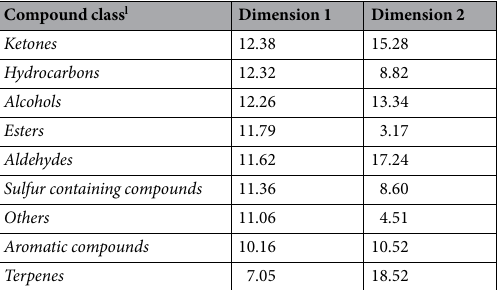
Table 2. Compound classes and their relative contribution to the MFA dimensions for the PTR-TOF analysis. Each dimension of a multivariate analysis can be described by the variables that are used to construct the factorial axes. l Compound classes are sorted according to their relative contributions to dimension